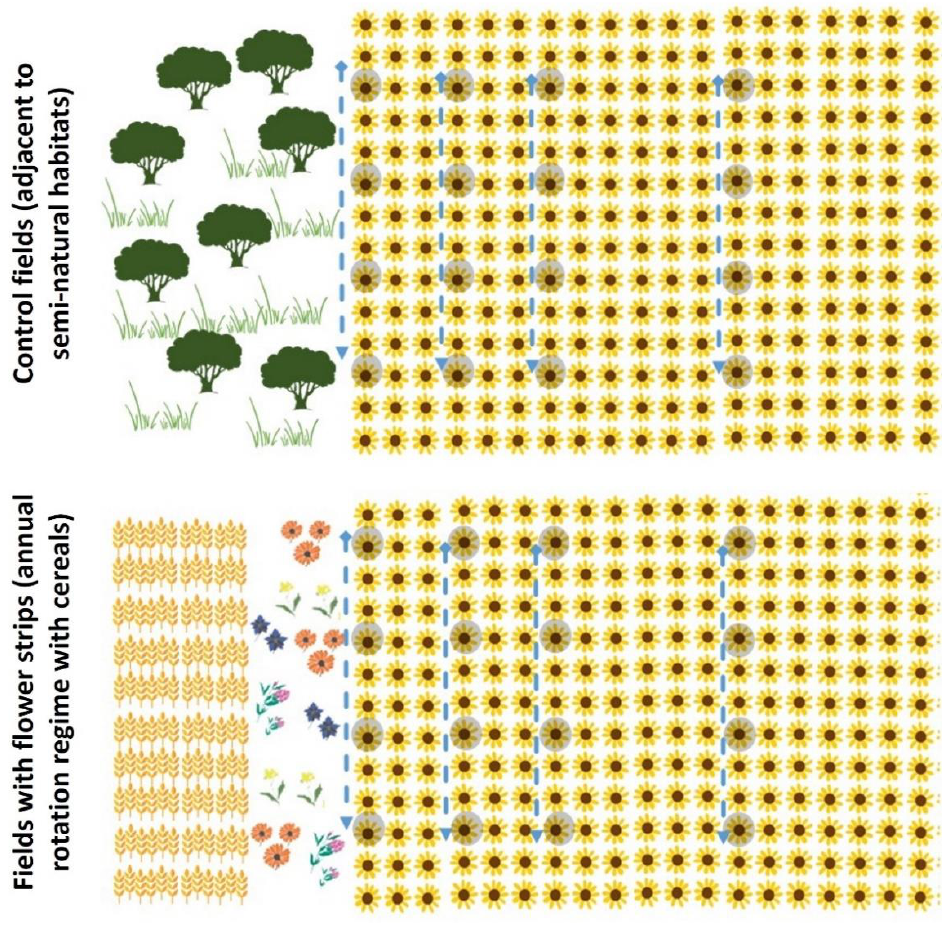
Figure 2. Schematic representation of the sampling design in sunflower fields with flower strips installed ( bottom ) and sunflower fields adjacent to semi-natural habitats ( top ) (modified from Hevia et al. [25]).